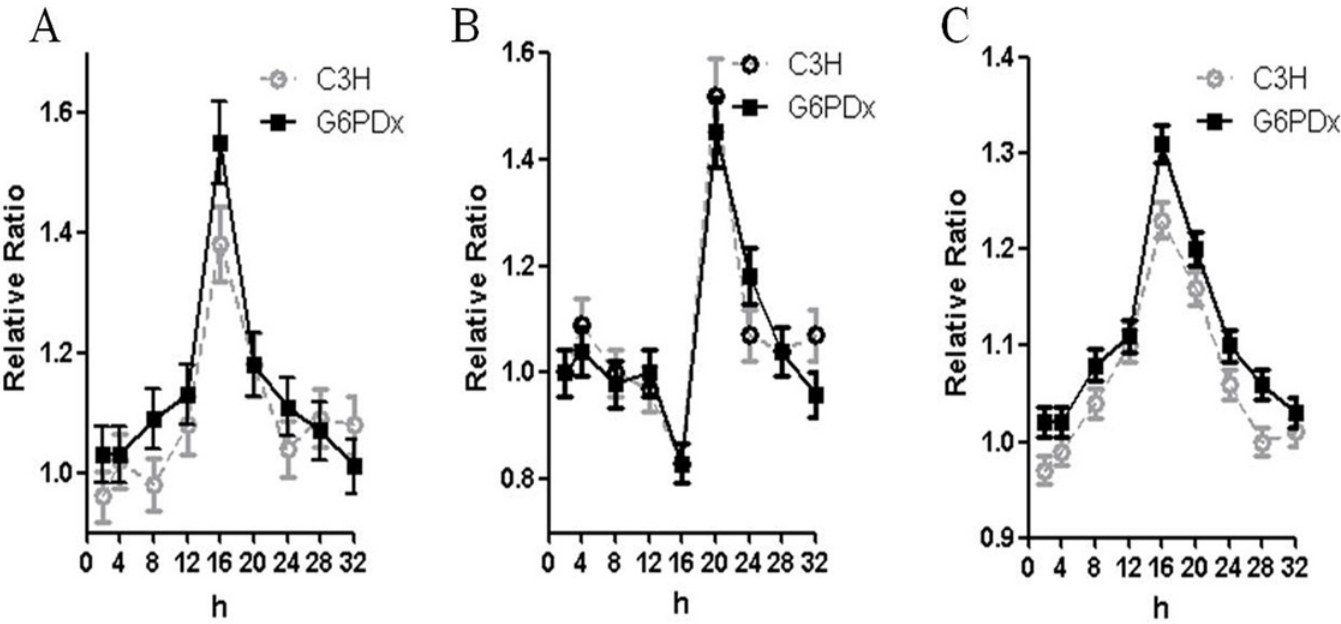
Fig 1. Kinetics of the changes of ROS, GSH, and MDA in response to fava beans in red blood cells of C3H and G6PDx mice. Results are presented as the relative ratios of ROS, GSH, and MDA in red blood cells of C3H-FB mice and G6PDx-FB mice to those in red blood cells of C3H control mice and G6PDx control mice, respectively. A. The relative ratio changes of ROS. B. The relative ratio changes of GSH. C. The relative ratio changes of MDA.